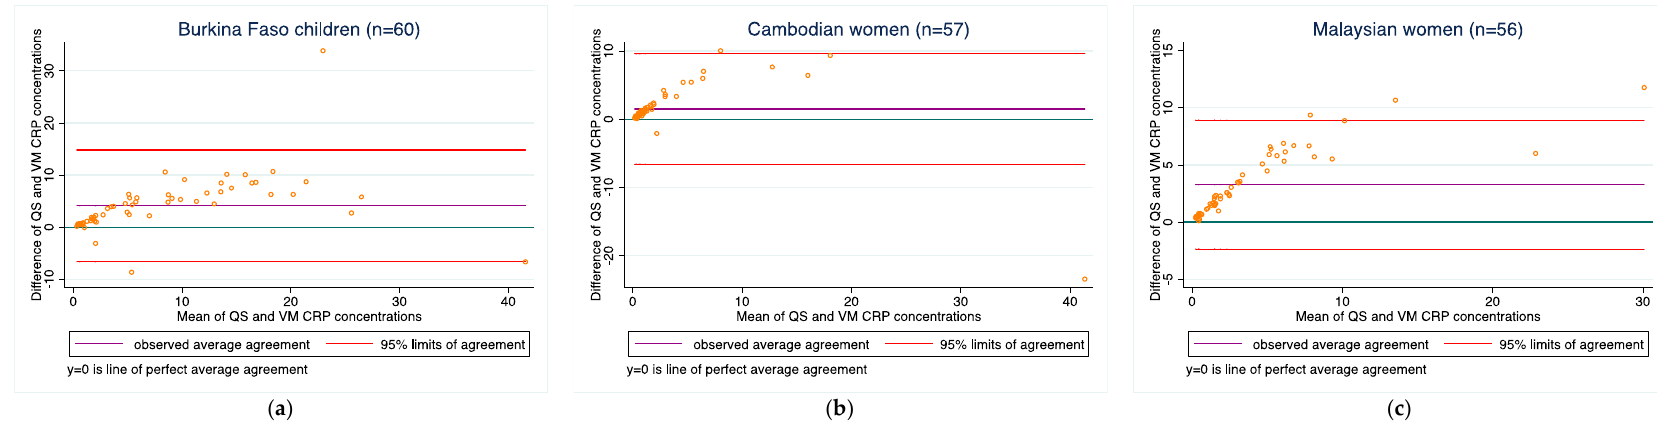
Figure 4. CRP concentrations for ( a ) Burkina Faso children ( n = 60); ( b ) Cambodian women ( n = 57); and ( c ) Malaysian women ( n = 56).